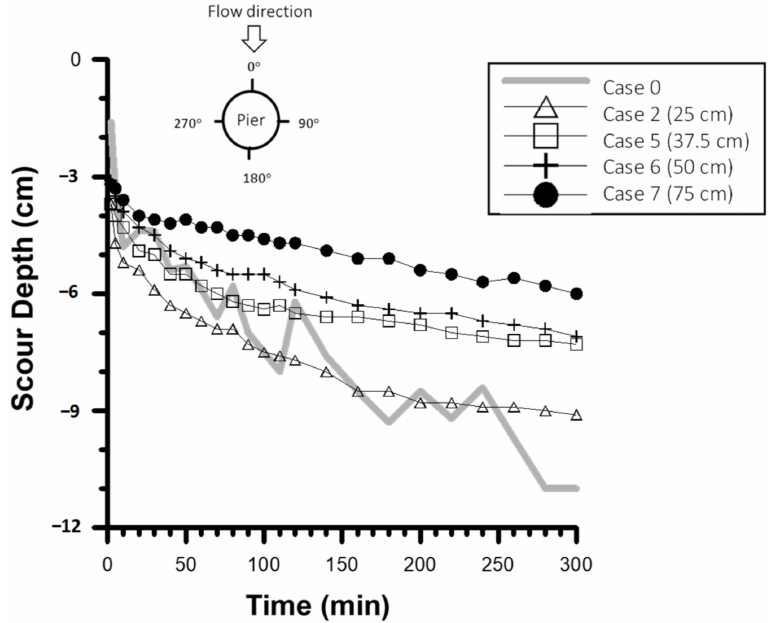
Figure 16. Developing history of scour depth at 0 ◦ of pier due to different strip lengths.